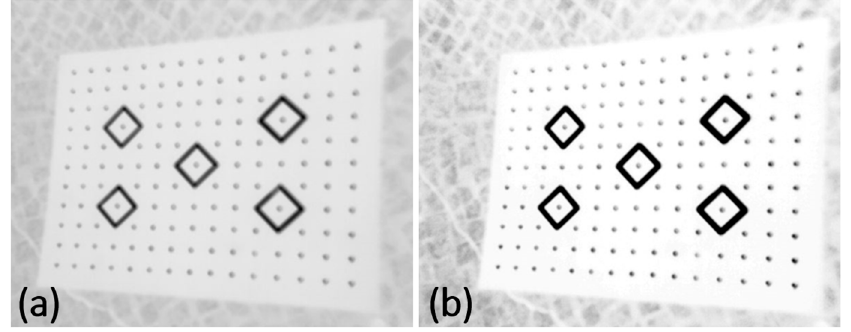
Figure 14. ( a ) raw image ( b ) sharpness enhancement by adjusting brightness and contrast.